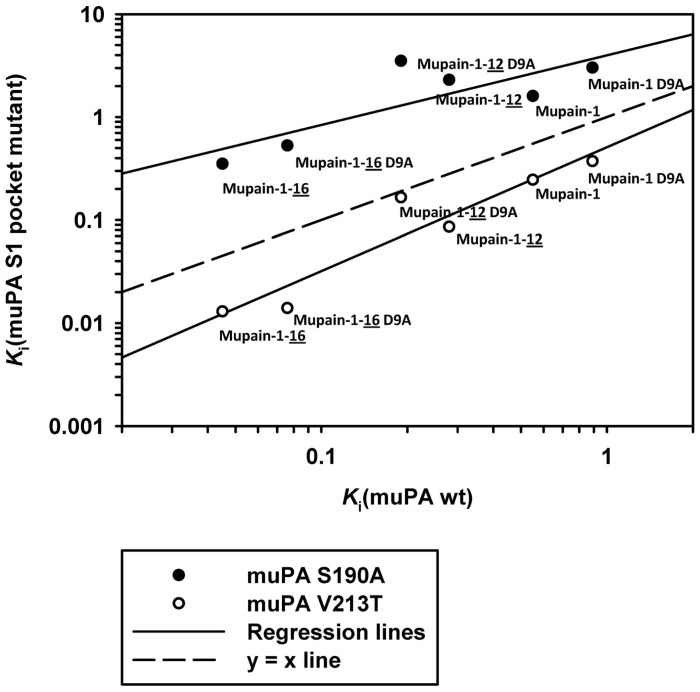
The relationship between the K
i values for inhibition of muPA S1 mutants and the K
i values for inhibition of muPA wt.The figure is based on the K
i values presented in Table 6. The x-axis shows the K
i values for inhibition of muPA wt by the indicated peptides. The y-axis shows the corresponding K
i values for inhibition of muPA S190A (filled dots) or muPA V213T (open dots). The lines resulted from simple linear regression analysis. The slopes of the lines are 0.68 (muPA-S190A) and 1.27 (V123T). The stippled line is the one which would have resulted if the K
i values for inhibition of the muPA S1 mutants had been identical to those for inhibition of muPA wt (y = x).